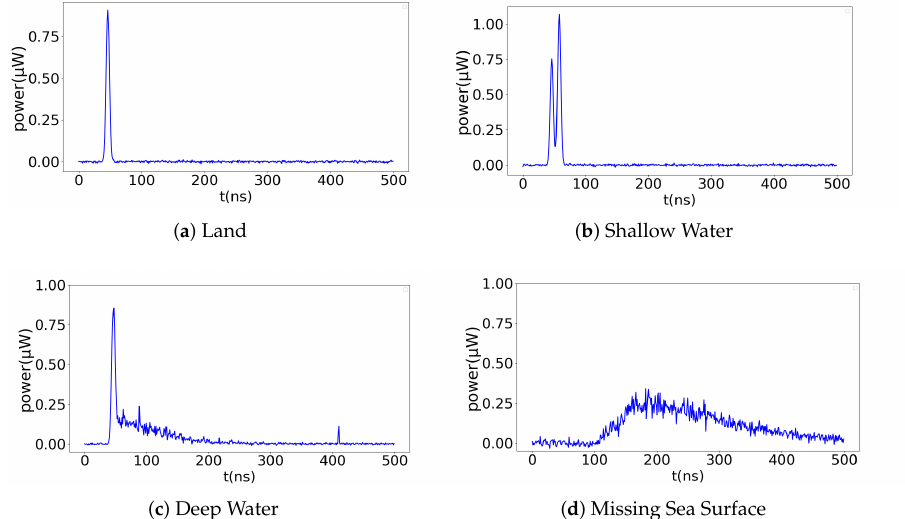
Figure 4. Bathymetry full